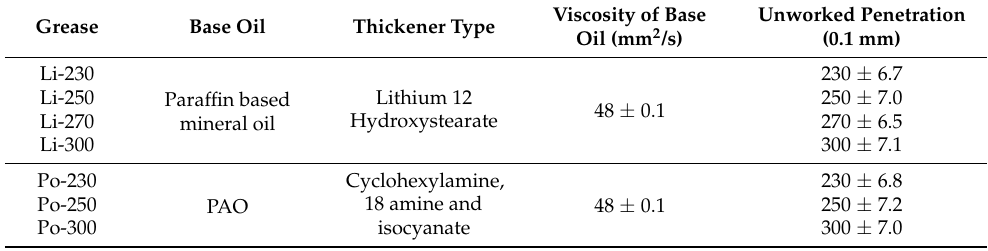
Table 1. Main components and properties of the tested greases.